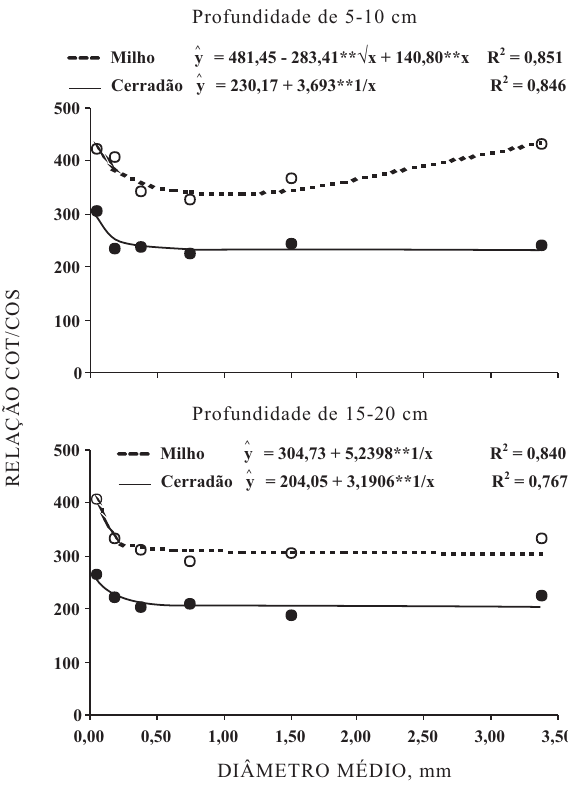
Figura 4. Relação entre o carbono orgânico total e o carbono orgânico solúvel em água (relação COT/COS), em função do diâmetro médio dos agregados, nas profundidades de 5–10 e 15–20 cm de um Latossolo Vermelho sob vegeta- ção natural de Cerradão e sob cultivo com milho por 30 anos. **: significativo a 1 % pelo teste